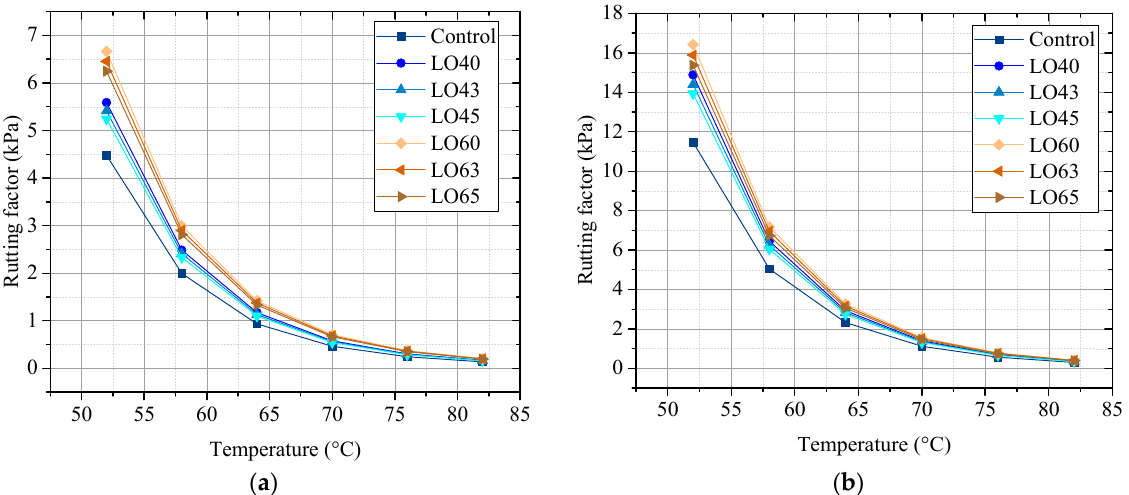
Figure 5. Rutting factor of the unaged and the RTFO-aged asphalt binders. ( a ) The unaged; ( b ) The RTFO-aged.